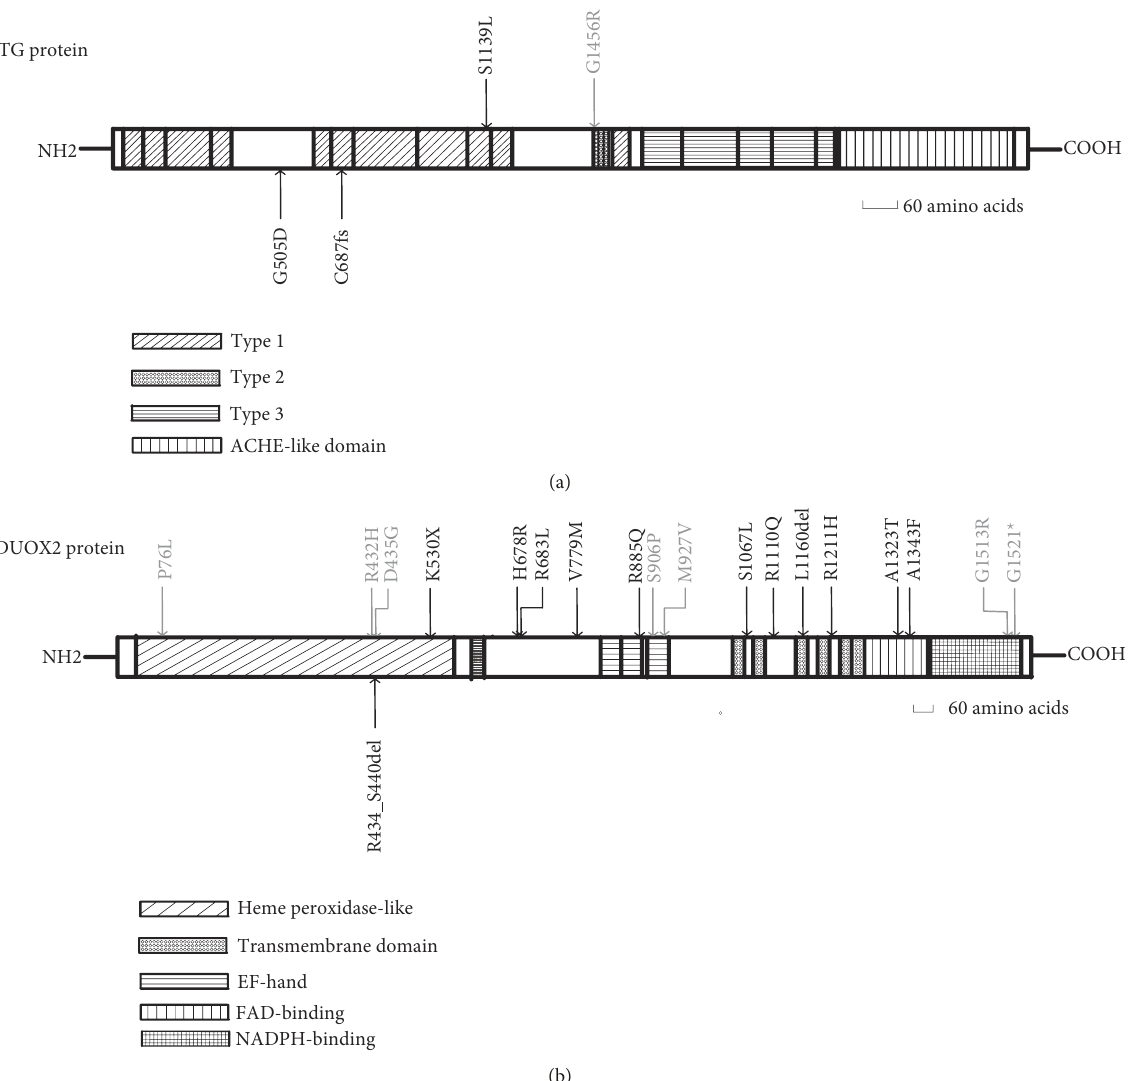
Figure 2: Location of detected missense or indel variants in TG and DUOX2 proteins. (a) Four mutations in TG. The repetitive units (types 1, 2, and 3) and ACHE-like domain are represented by boxes [19]. (b) Nineteen variants, including two functional SNPs, in DUOX2. The relative positions of the transmembrane domain, heme peroxidase-like domain, calcium-binding (EF-hand), fl avine adenine dinucleotide- (FAD-) binding, and reduced nicotinamide adenine dinucleotide phosphate- (NADPH-) binding motifs are indicated [46]. Labeled variants (top) represent previously reported variants. Variants previously reported in the literature are shown in black, and those reported only in public population databases are shown in gray. Labeled variants (bottom) are novel variants identi fi ed in the present